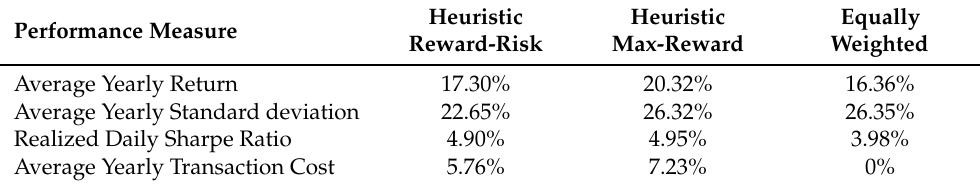
Table 2. Summary out-of-sample investment performance for the 1000